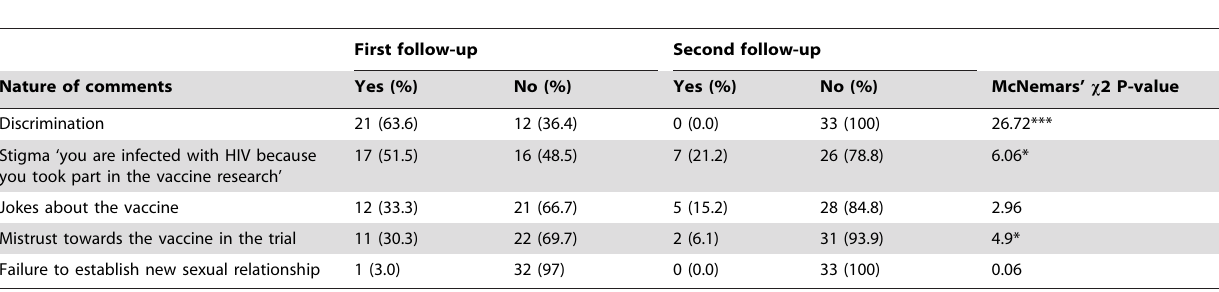
Table 5. Types/nature of negative comments/reactions received from other people (non- vaccine participants) and the effects of words in the relationships.